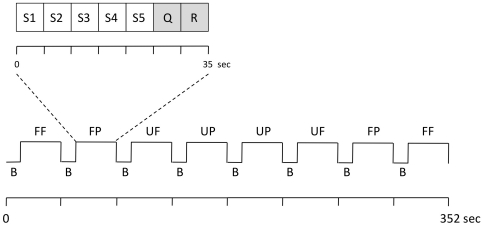
fMRI paradigm.This figure visualizes one experimental run of the fMRI paradigm. Three of these runs, each lasting 352 s, were performed. The order of the four conditions (FF, UF, FP, UP) was counterbalanced across the runs. Each block (35 s) of a condition consisted of a visual stimulus presented from five different angles (S1-5), a familiarity question (Q), and a response (“thank you”, R). FF = familiar face, UF = unfamiliar face, FP = familiar place, UP = unfamiliar place, B = baseline (fixation cross, 9 s).